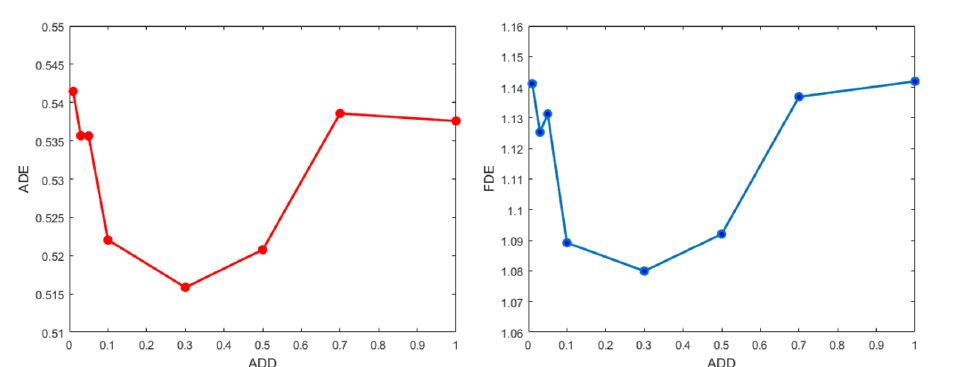
Figure 5. Results comparison of average ADE ( left ) and FDE ( right ) on different accuracy discrimina- tion distance ADD . When ADD is 0.3, the network can achieve better performance, so ADD is set to